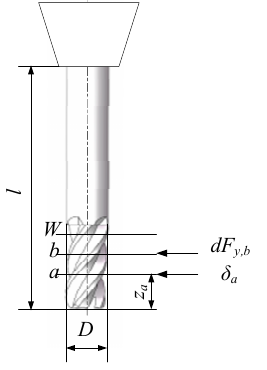
Figure 7. Flexible deformation model of the end milling tool.